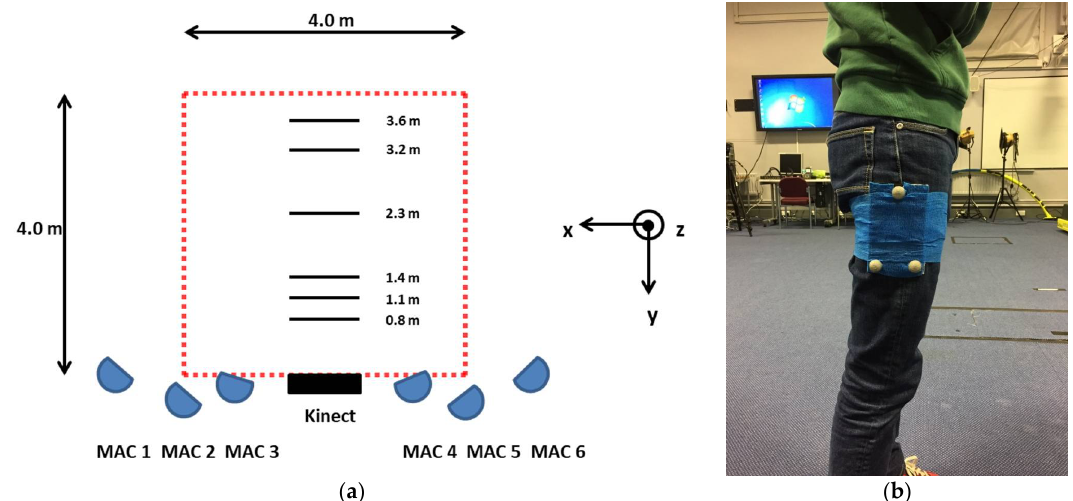
Figure 2. ( a ) Schematic of laboratory setup; ( b ) marker-triad configuration when applied to